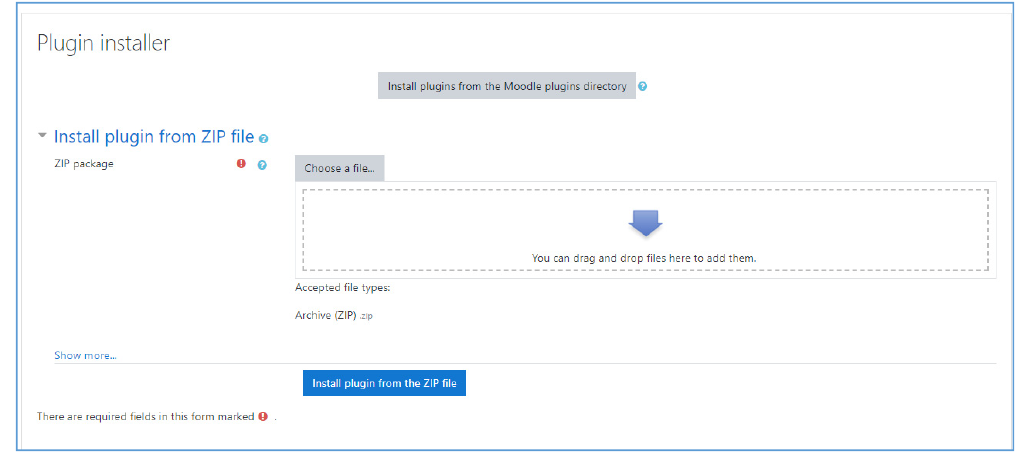
Figure 1. Installing the “eOrientation” plugin.